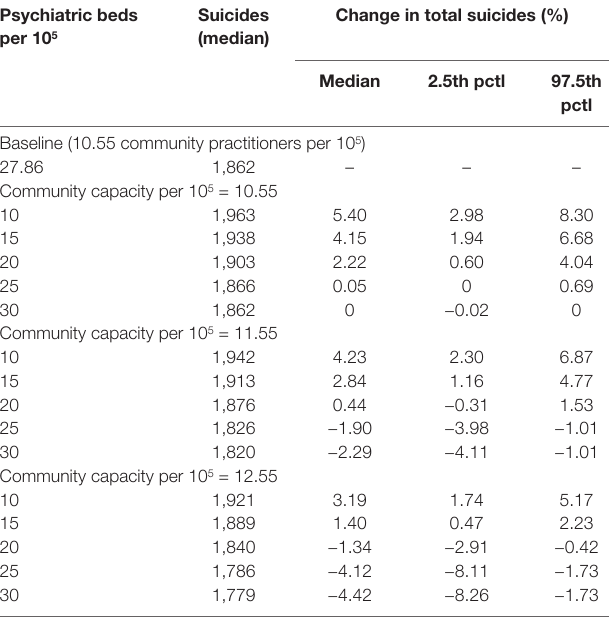
TABLE 1 | Sensitivity analysis